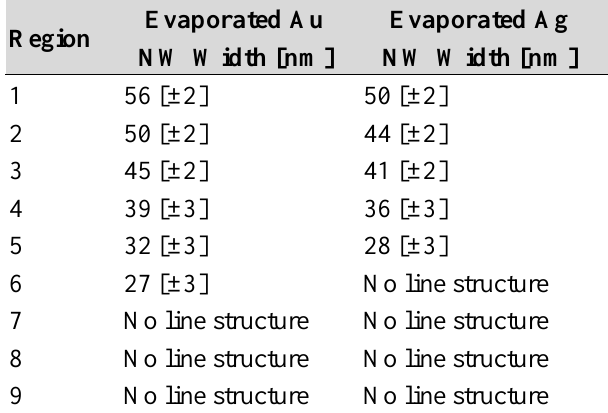
Table 1. A summary of mean nanowire (NW) widths for the evaporated Au & Ag nanowire arrays used in this work. The values are based on the estimated mean values of SEM images of four Au chips and two Ag chips from the same production batch. In height, all nanowires have a 2 nm adhesion layer of chrome and 15 nm of gold or